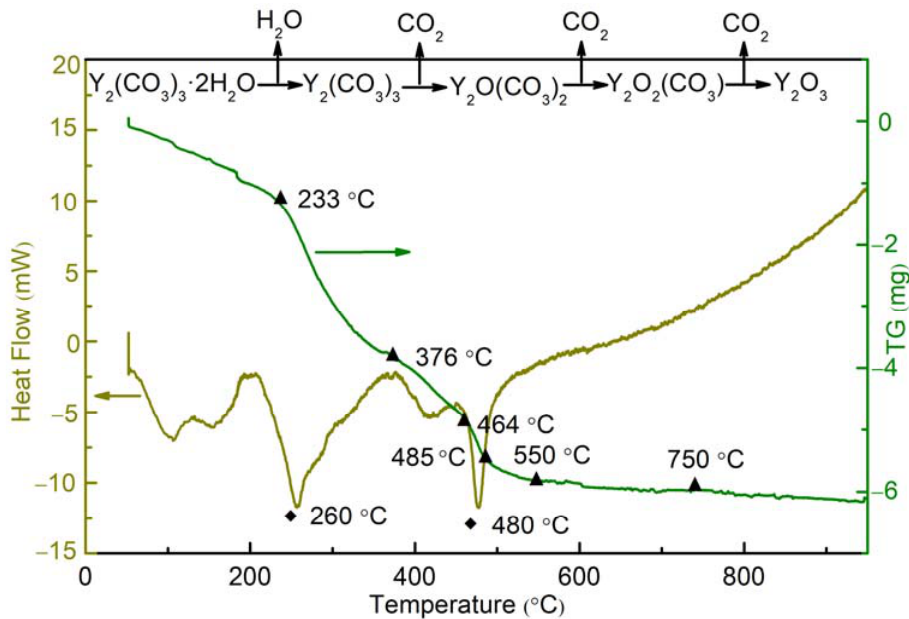
Figure 5. TG-DSC curves of yttria precursor.